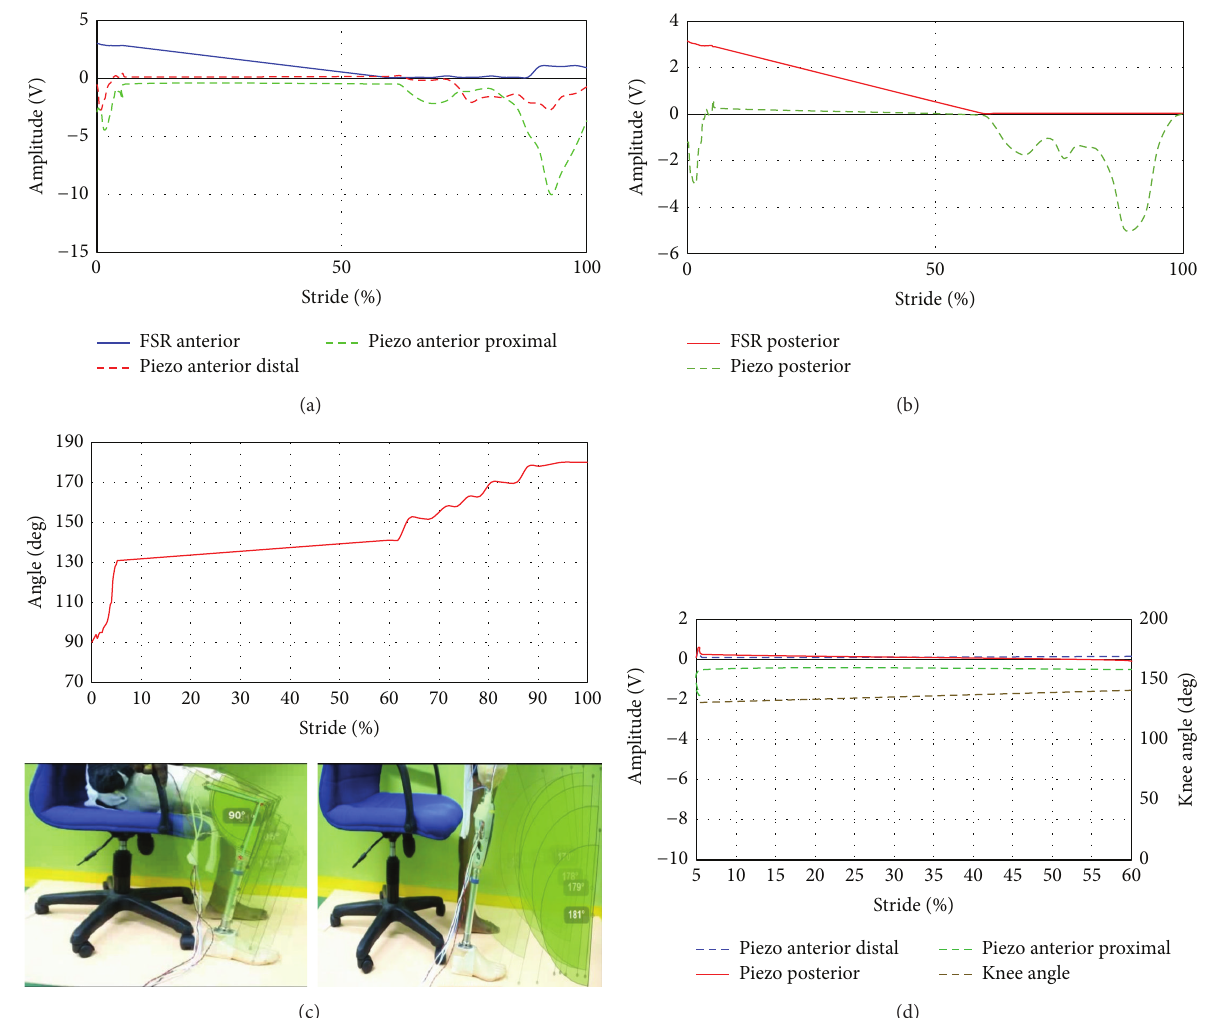
Figure 8: FSR and piezoelectric sensors output during sit to stand movement: (a) FSR anterior, piezo anterior distal, and piezo anterior proximal sites, (b) FSR and piezoelectric sensors at posterior sites, (c) knee angle during stride, and (d) piezoelectric sensors with the knee angle at a region from 5% to